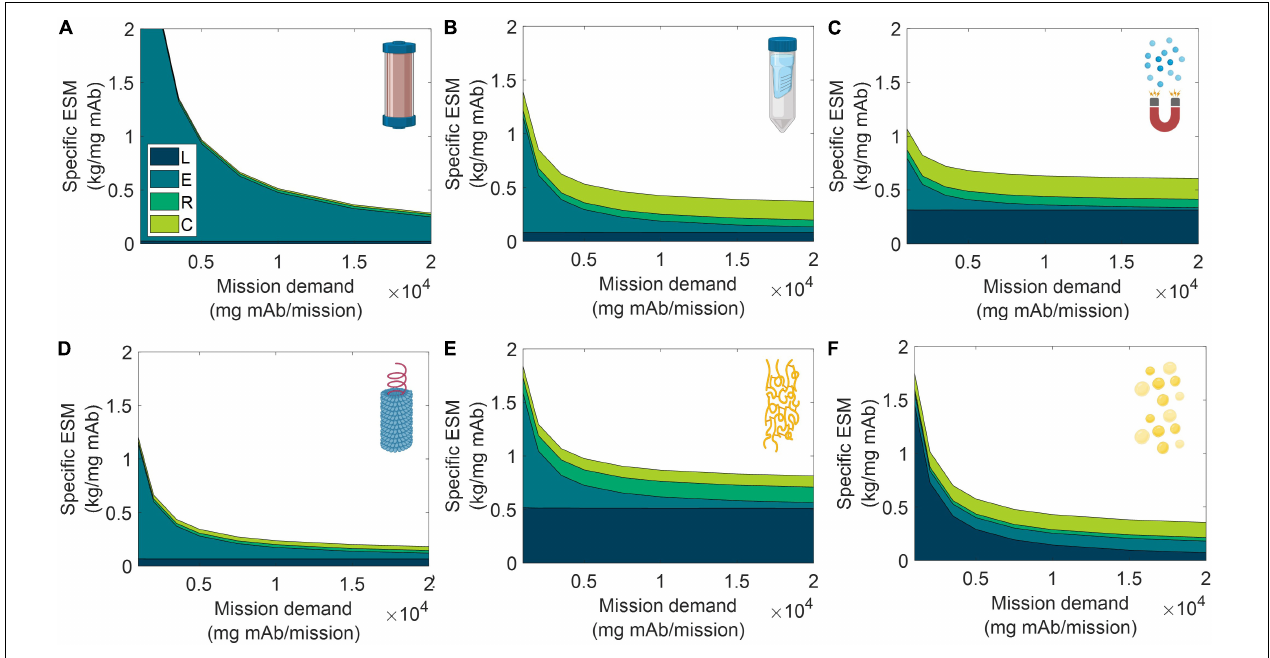
FIGURE 7 | Specific equivalent system mass (per unit mass monoclonal antibody produced) broken down by labor (L), equipment (E), raw materials (R), and consumables (C) cost categories as a function of mission production demand for monoclonal antibody for (A) CHM, (B) SPN, (C) MAG, (D) VIN, (E) ELP, and (F) OLE. CHM, pre-packed chromatography; SPN, spin column; MAG, magnetic bead; VIN, plant virus-based nanoparticle; ELP, elastin-like polypeptide; OLE,